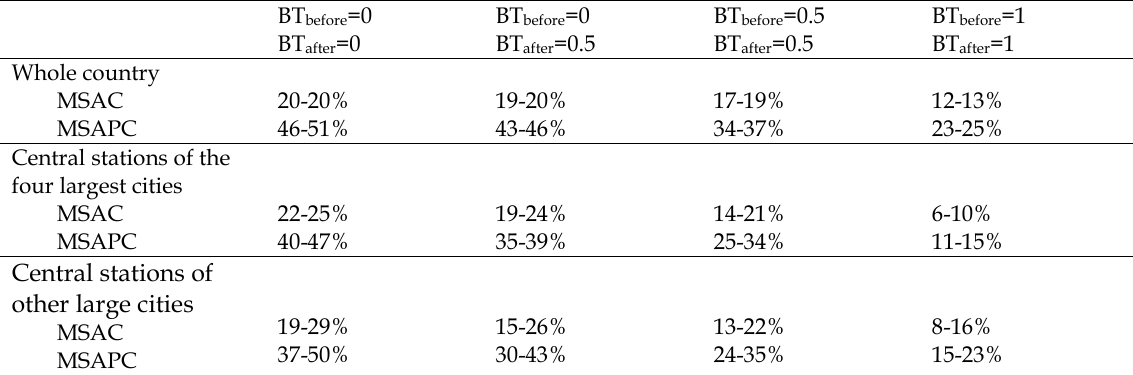
Potential capacity reduction for different buffer times